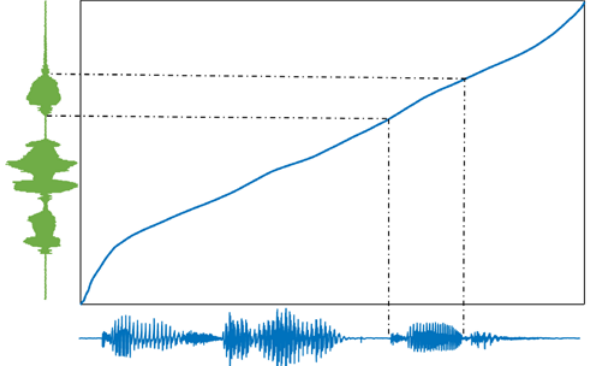
Figure 4 | Example of time-warping path between a reference (vertical axis) and repeated (horizontal axis) speech signals. The dashed lines connect the boundaries of the same distinct sound in both